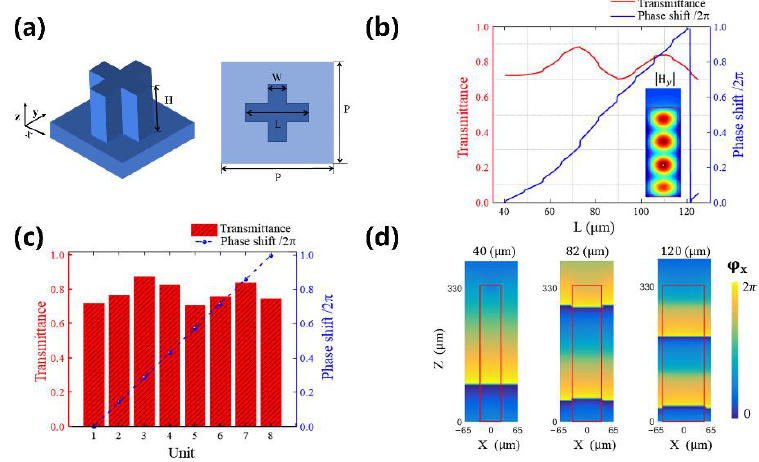
Figure 2. Characterization of the designed unit cell for modulating the propagation phase. ( a ) Schematic of the unit cell: the lattice constant P, the unit length L, the width W, and the height H. ( b ) Transmittance and phase shifts as a function of the unit length L. The inset illustrates the side views of the simulated magnetic amplitude distributions of the unit cell with L = 120 μm. ( c ) The phase shifts and transmittance of eight selected silicon units. ( d ) Simulated phase wavefront in three silicon units with L = 40, 82, and 120 μm, respectively.